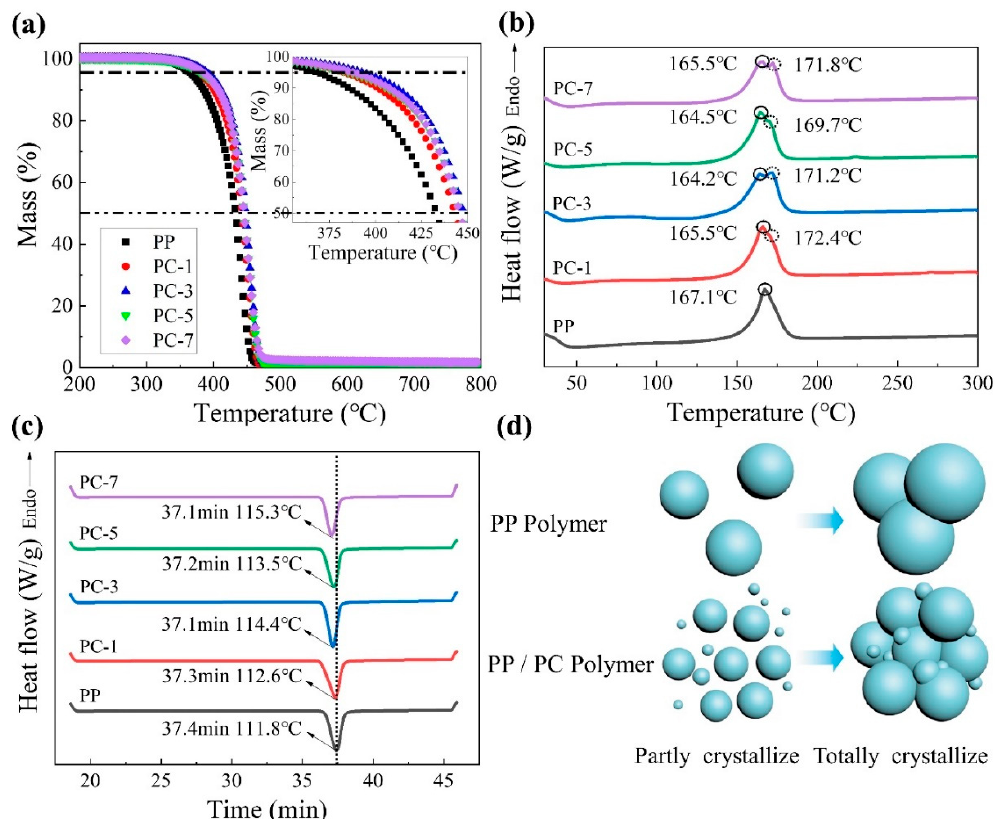
Figure 3. ( a ) Thermogravimetric (TG) thermograms; differential scanning calorimetry (DSC) thermograms; ( b ) First heating; ( c ) cooling; and ( d ) the nucleation processes of polypropylene (PP)/polycarbonate (PC) meltblown membranes. Table 3. Thermal properties of the membranes.